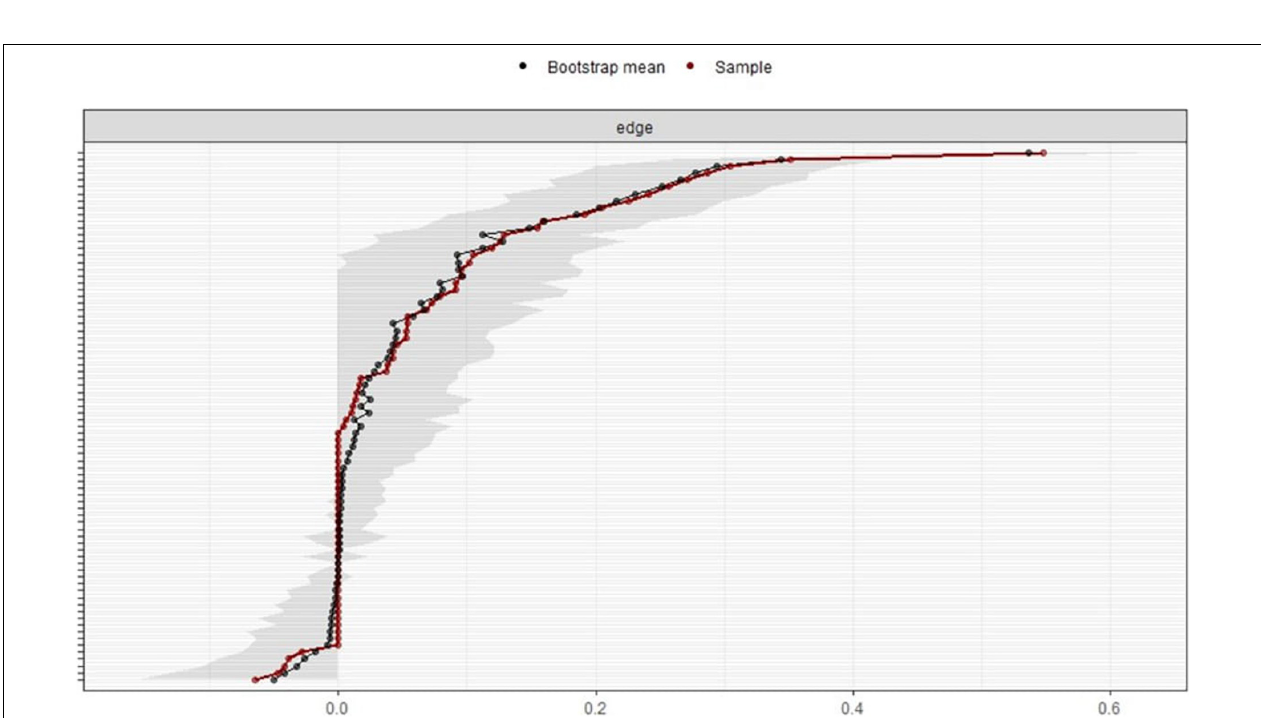
FIGURE 6 | Bootstrapped confidence intervals of estimated edge-weights for the estimated network. The red line shows the sample values, and the gray area shows the bootstrapped CIs. Each horizontal line represents one edge of the network. The top is the highest edge-weight, and the bottom is the lowest edge-weight. Y-axis labels were removed to avoid